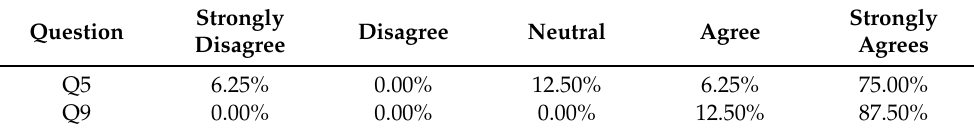
Table 6. Q5, Q9—User